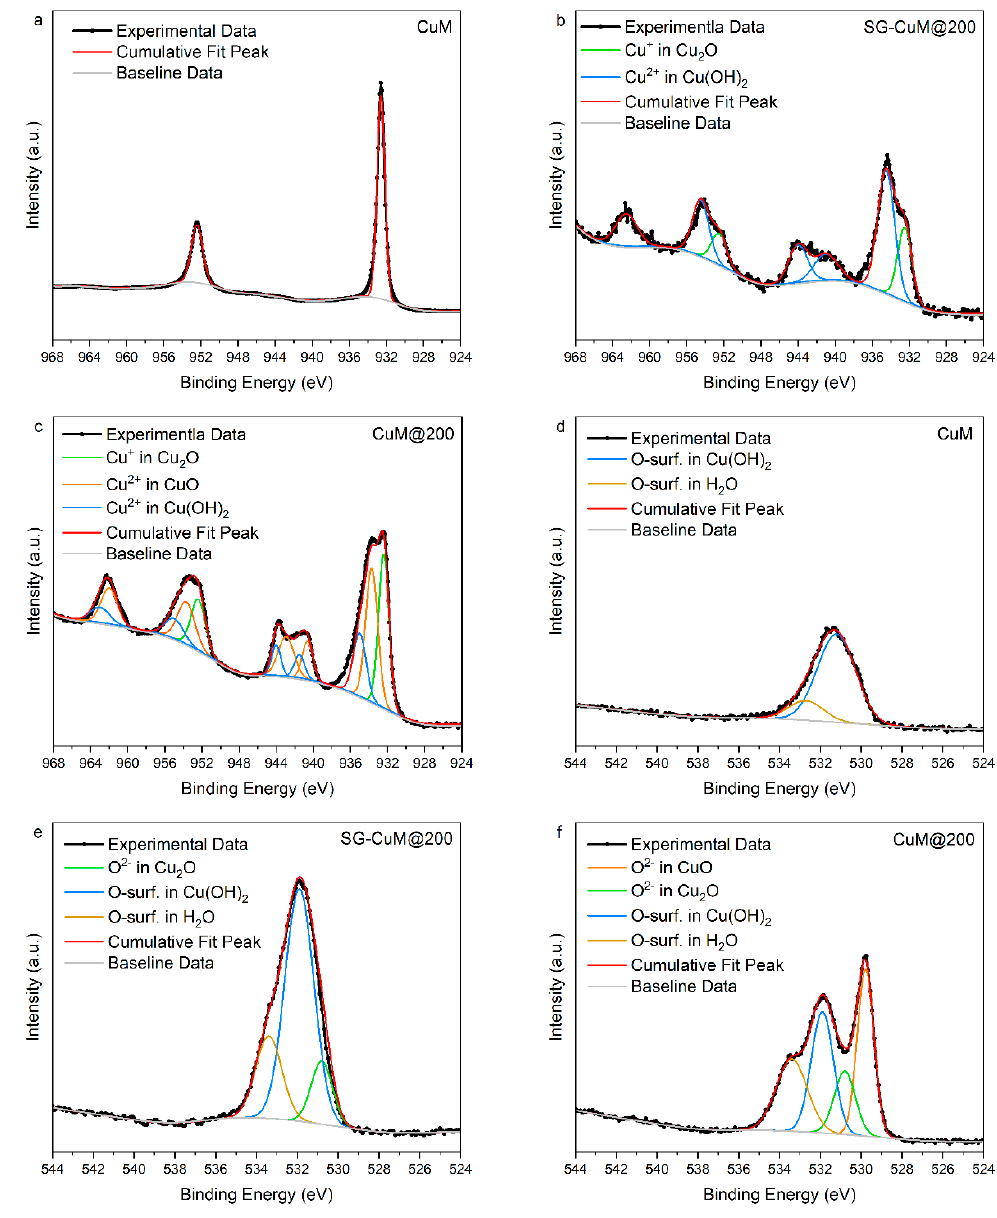
Figure 2. XPS spectra of ( a – c ) Cu 2p 3/2 and Cu 2p 1/2 core peaks and ( d – f ) O 1s core peaks for the as-